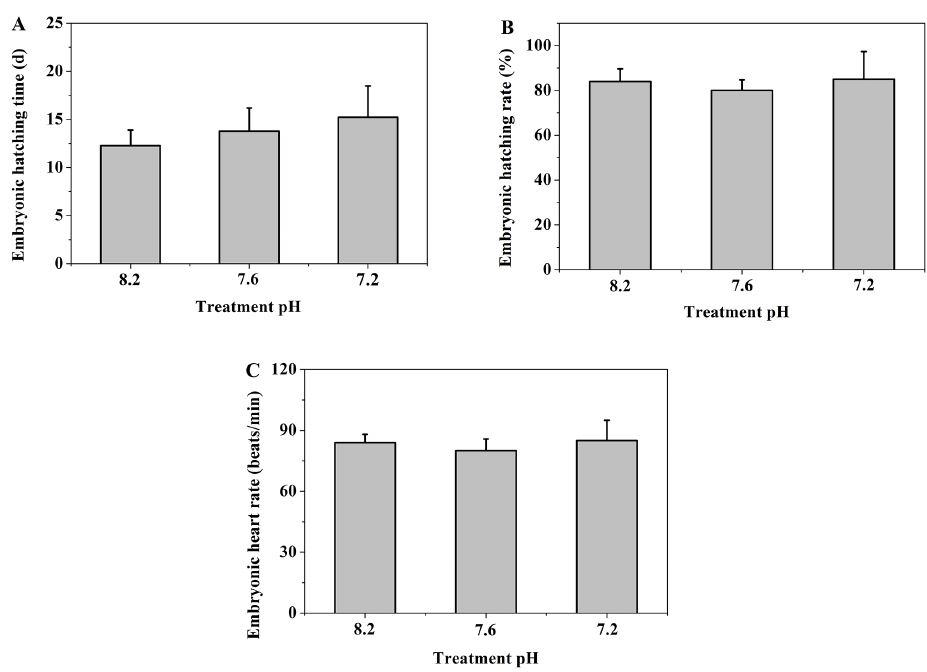
Figure 3. The hatching time, hatching rate, and heart rate of marine medaka embryos exposed to three pHlevels. (a) Hatching time; (b) hatch- ing rate; (c) heart rate.